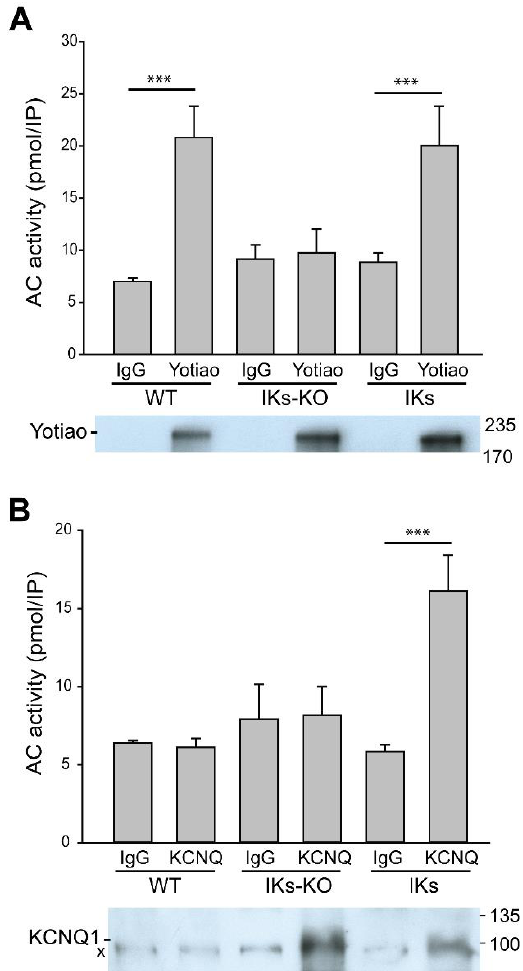
Figure 1. AC9 association with Yotiao and KCNQ1. Heart extracts from WT, IKs or IKs-AC9KO mice were subjected to immunoprecipitation (IP) with IgG (rabbit) or anti-Yotiao ( A ) and goat IgG or anti-KCNQ1 ( B ). The resulting immunoprecipitate was stimulated with 300 nM Gαs to measure AC activity. Data are shown as mean +/ − SD. A portion of the IP’s from each sample was subjected to WB analysis for Yotiao ( A ) or KCNQ1 ( B ) and are shown below. Statistics: Kruskal-Wallis Analysis of Variance followed by Dunn’s or Bonferroni’s comparison method. n = 6–8, *** p < 0.001.